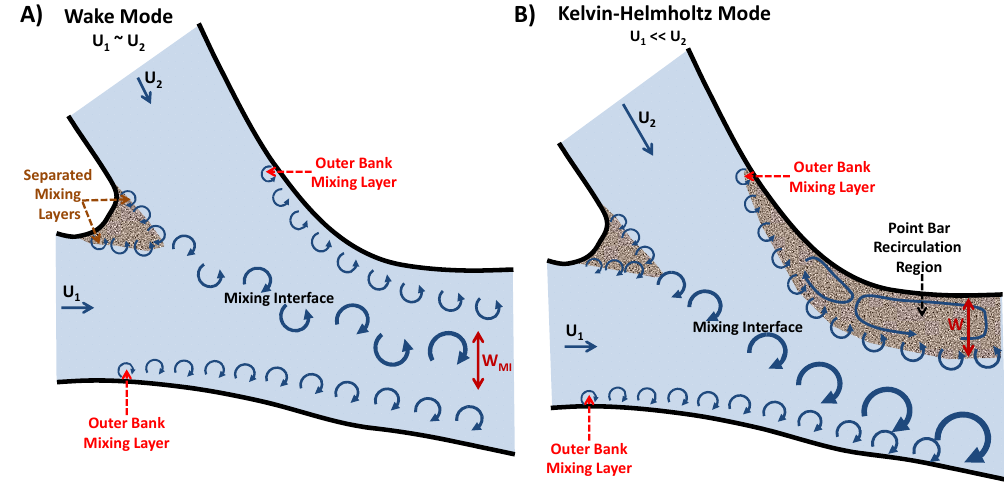
Fig. 14. Flow field schematics of a stream confluence with a small velocity ratio between converging streams (A) and with a large velocity ratio between converging streams (B) . (Figure adapted from the work of Miyawaki et al., 2010 and Constantinescu et al.,